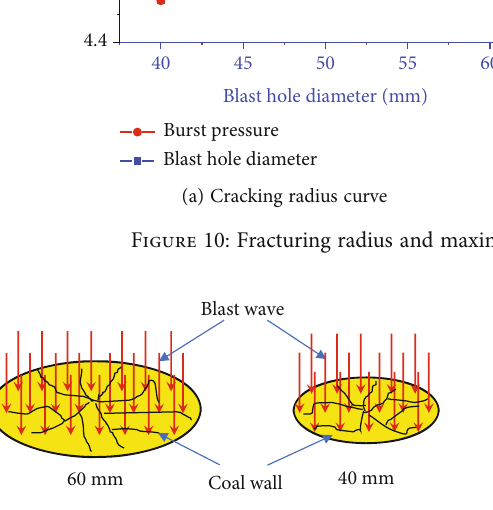
Figure 11: Schematic diagram of coal body under di ff erent vent diameters.